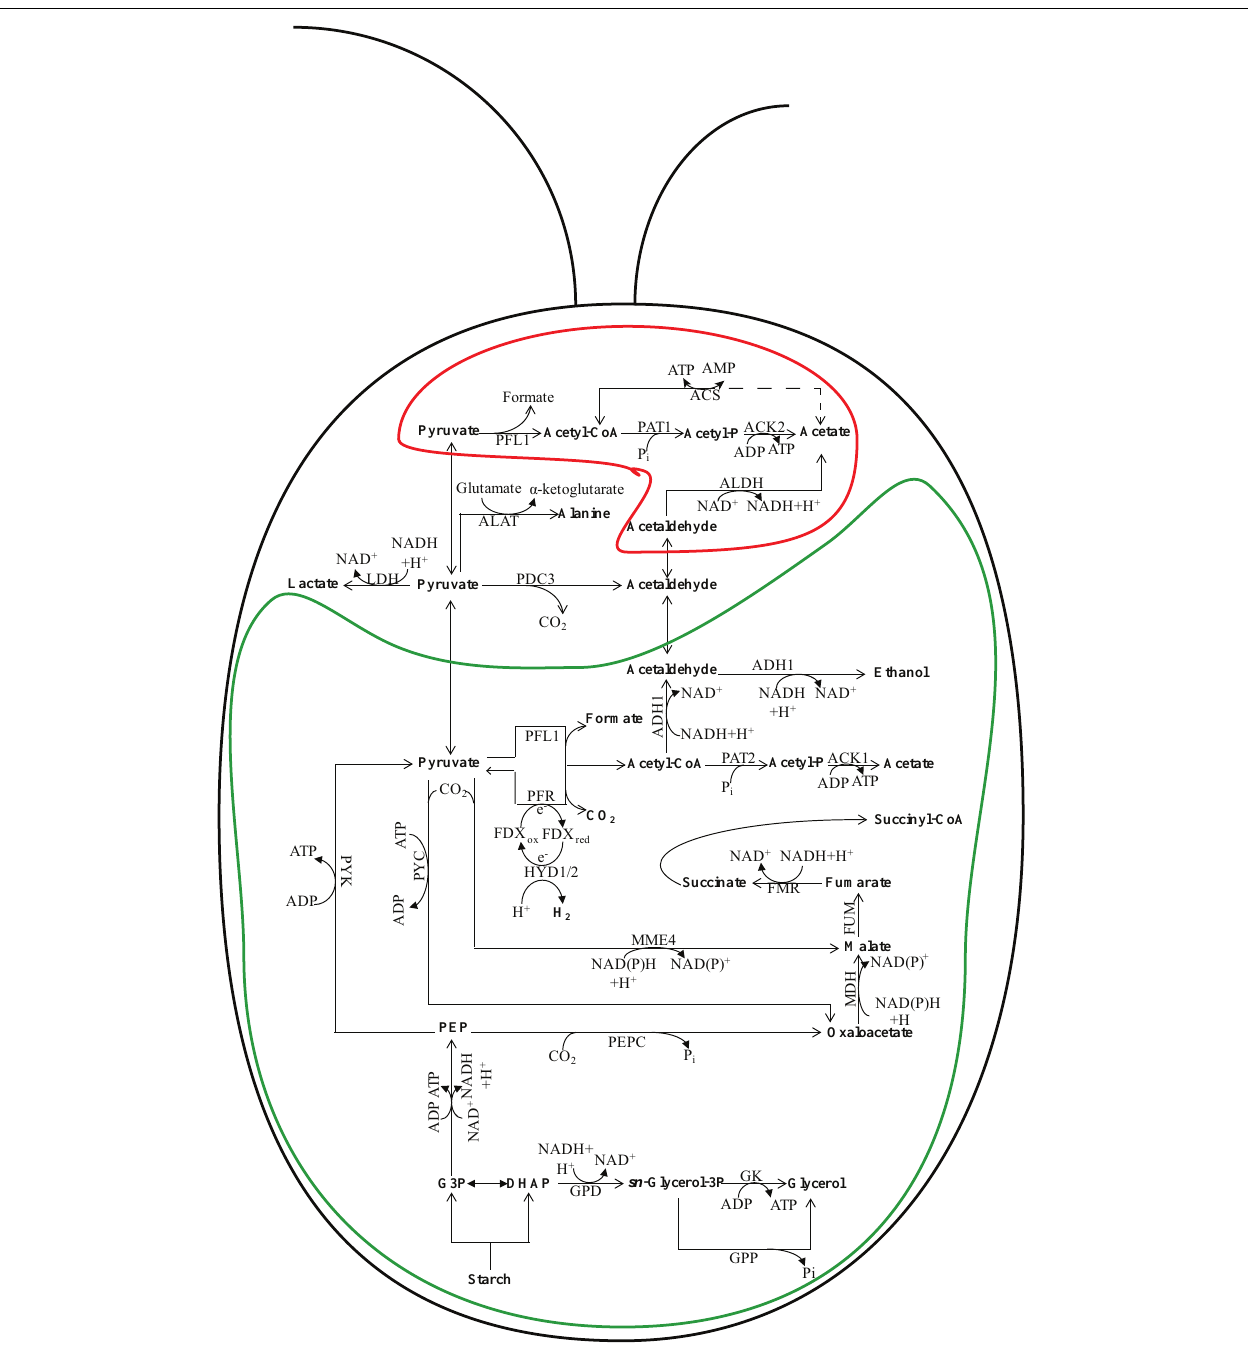
FIGURE 2 | Fermentation pathways in Chlamydomonas . In wild-type (WT) Chlamydomonas cells, the major fermentative products are formate, acetate, and ethanol, with CO 2 and H 2 generated as minor products.The pathway leading to fermentative succinate generation is not readily detected inWT cells grown under laboratory conditions, but becomes prominent in the hydEF-1 mutant (Dubini etal., 2009). An increase in lactate production, which is almost undetectable in fermentingWT cells, is observed in the pfl1 mutants (Philipps etal., 2011; Burgess etal., 2012; Catalanotti etal., 2012). Glycerol accumulation occurs in the adh1 single and the pfl1–1adh1 double mutants (Catalanotti etal., 2012; Magneschi etal., 2012).The protein designations in this figure are: FMR for fumarate